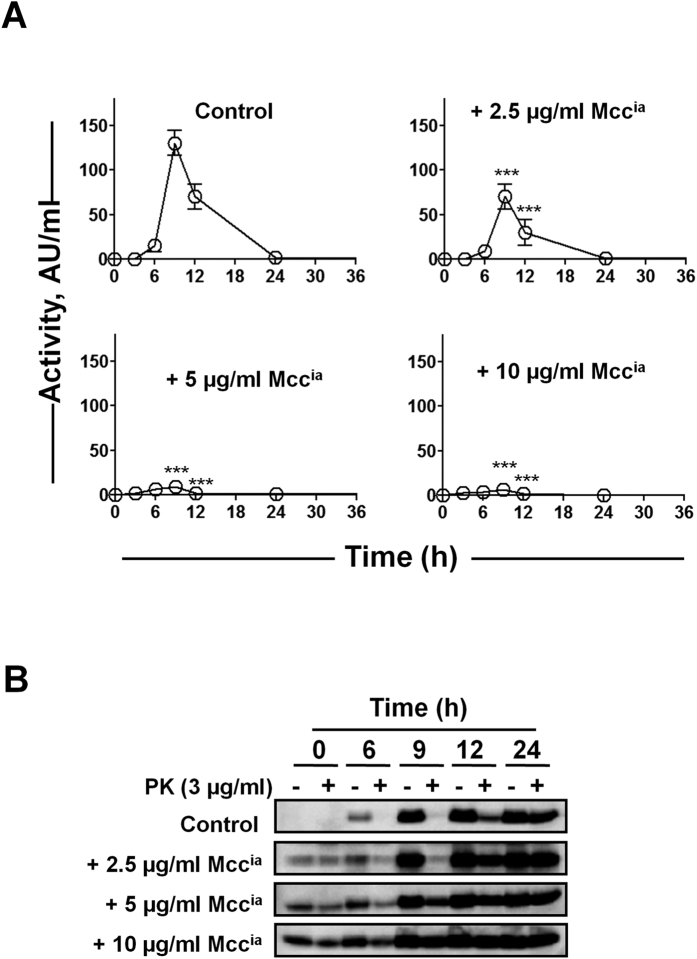
Purified in vitro-generated Mccia induces the conversion of Mcca into Mccia
in vivo.(A) E. coli VCS257pJEM15 was grown in minimal medium at 37 °C either in the absence (control) or in the presence of purified Mccia (2.5, 5 and 10 μg/ml, final concentration; see “Materials and Methods”). Aliquots were removed at indicated time points and Mcc activity was measured by CDM. Activity was measured in duplicate samples and error bars indicate S.D. The differences in Mcc activity between control and treated samples were highly significant (P < 0.0001) in both variables (time and treatment, as well as the interaction between them) as measured by two-way ANOVA. Post-hoc analysis by the Bonferroni test revealed also significant differences between treatment and controls at times 9 and 12 h (***P < 0.001). (B) Immunoblots of aliquots removed from culture used in panel A before (−) and after treatment ( + ) with PK (3 μg/ml) at indicated time points.